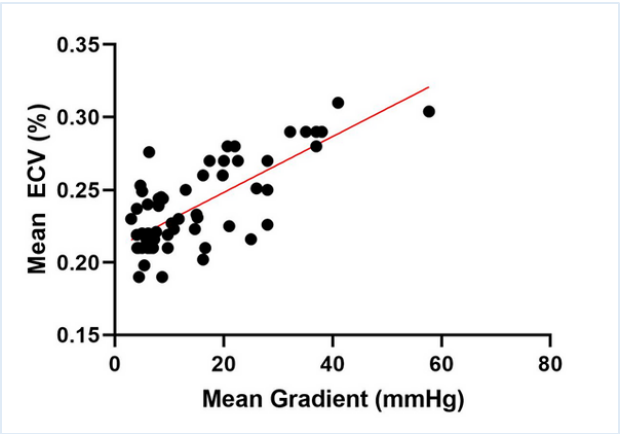
Figure 1. Endocardial and epicardial borders were traced manually on the LV. The LV was automatically divided into 6 equal segments (1=anterior, 2=antero-lateral, 3=infero-lateral, 4=inferior, 5=infero-septal and 6=an- tero-septal) and the mean T1 relaxation time was calculated for each seg-